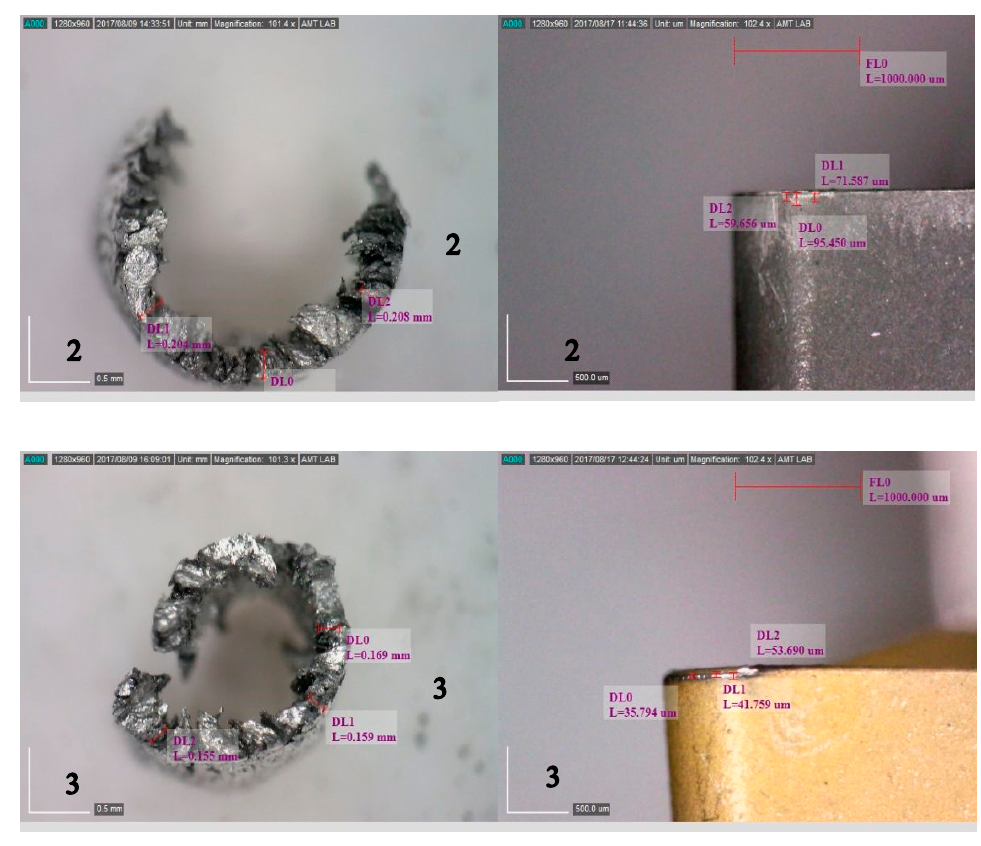
Figure 12. Images of chips and tool wear for dry and MQL machining parameters: A-60, B-0.15, C-1, D-0, E-15% ( 1 ), A-30, B-0.2, C-1, D-100, E-15% ( 2 ), A-60, B-0.15, C-1, D-0, E-15% ( 3 ).